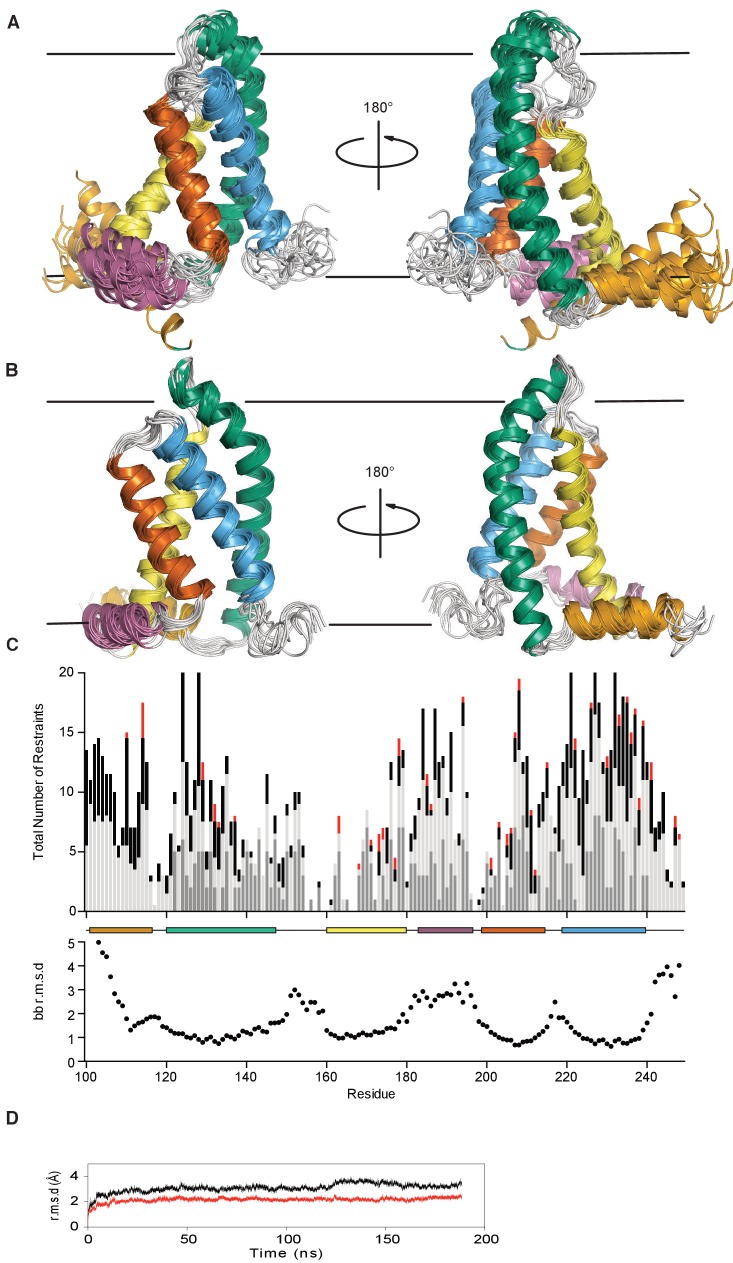
KCNQ1-VSD XplorNIH-determined structural ensemble, before and after molecular dynamics refinement.(A) The ensemble is comprised of the top 15 lowest energy structures out of 150 conformations generated by NMR data-restrained XPLOR-NIH calculations (no bilayer). The transmembrane helices S1, S2, S3, and S4, are colored bluish green, yellow, vermillion, and sky blue respectively. The S2-S3 linker and S0 helices are colored orange and reddish purple. The loop between S1 (bluish green) and S2 (yellow) appears disordered due to lack of NMR-derived restraints. This does not necessarily mean this region does not adopt stable secondary structure. The approximate position of the membrane is indicated by a pair of gray lines. (B) The unrestrained molecular dynamics refined ensemble (MD carried out in an explicit hydrated DMPC bilayer) colored as in panel A (corresponding to PDB ID 6MIE containing 10 conformers). (C) The upper panel shows the total number of distance restraints per residue. For NOE-derived restraints that define a distance between two atoms in different residues, each residue receives a count of 0.5 per restraint. Long range, medium, and sequence distance restraints are colored red, black, and light gray, respectively. For PRE-derived restraints, which define the distance between a given backbone amide and the MTSL free radical of the spin labeled residue, a count of 1.0 is added to the non-labeled residue. PRE-derived restraints are colored dark gray. The lower panel plots the backbone r.m.s.d. vs. residue number for the XPLOR-NIH ensemble. The helical sections of secondary structure are indicated with colored boxes corresponding to the cartoon representation. (D) The backbone r.m.s.d. to seed starting coordinates of the transmembrane helices (red) and all residues (black) over the course of the unrestrained trajectory is shown.Figure 2—figure supplement 1—source data 1.Text file with coordinates (PDB format) of the XPLOR-NIH structure ensemble for the KCNQ1-VSD prior to molecular dynamics.Figure 2—figure supplement 1—source data 2.Excel file with numerical data used for Figure 2—figure supplement 1C, top panel.Figure 2—figure supplement 1—source data 3.Excel file with numerical data used for Figure 2—figure supplement 1C, bottom panel.Figure 2—figure supplement 1—source data 4.Excel file with numerical data used for Figure 2—figure supplement 1D, top panel.